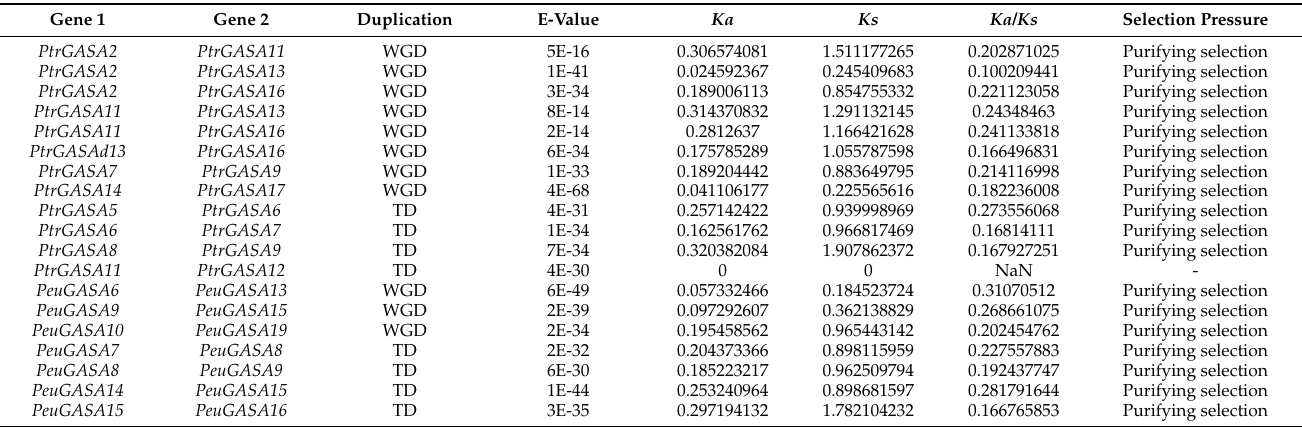
Figure 3. Analysis of the evolutionary relationship among GASA genes. ( a ) Evolution analysis of GASA gene family in P. trichocarpa ; ( b ) Collinear analysis of GASA gene family between the Arabidopsis and P. trichocarpa . Different sizes of fan rings represented different sizes of chromosomes. The colored lines represented collinear GASA gene pairs. Table 2. Duplications of GASA genes in P. euphratica